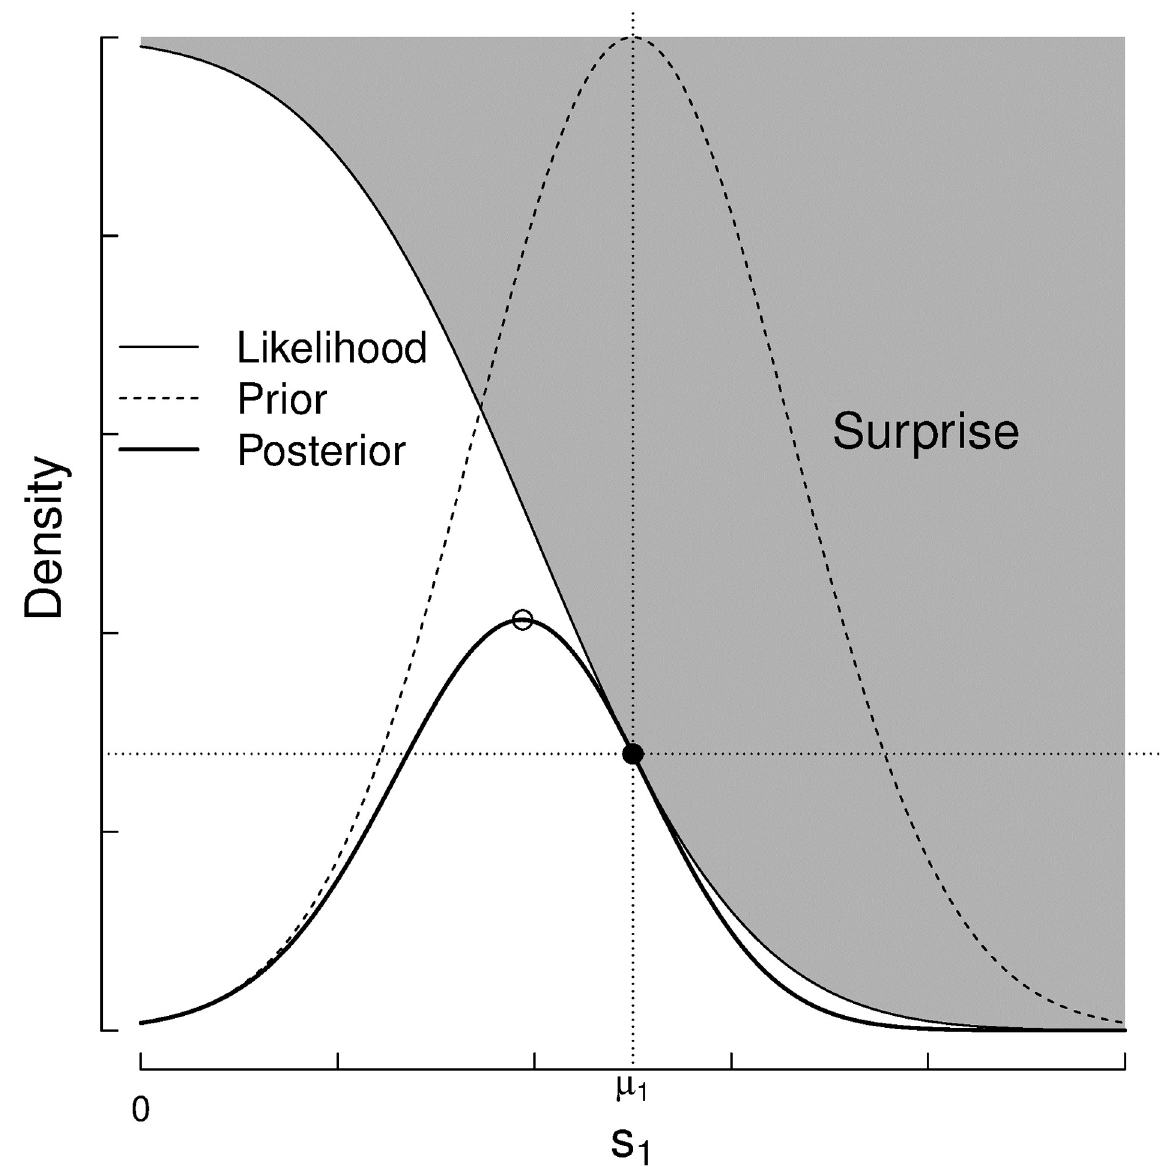
Fig 13. TrueSkill update procedure for losing case, where δ is the expected difference between teams.